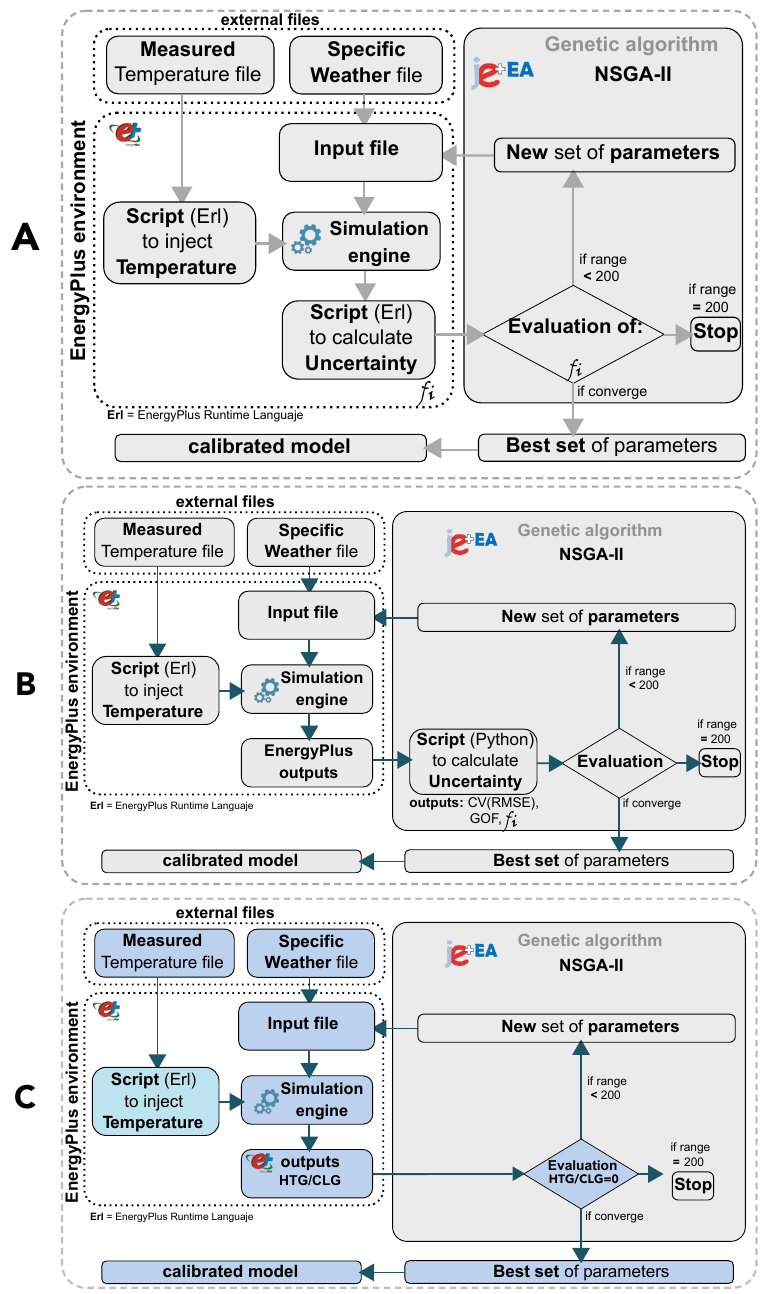
Figure 1. ( A ) First approach [27]; ( B ) Second approach [26]; ( C ) Present approach. CLG: cooling; HTG: